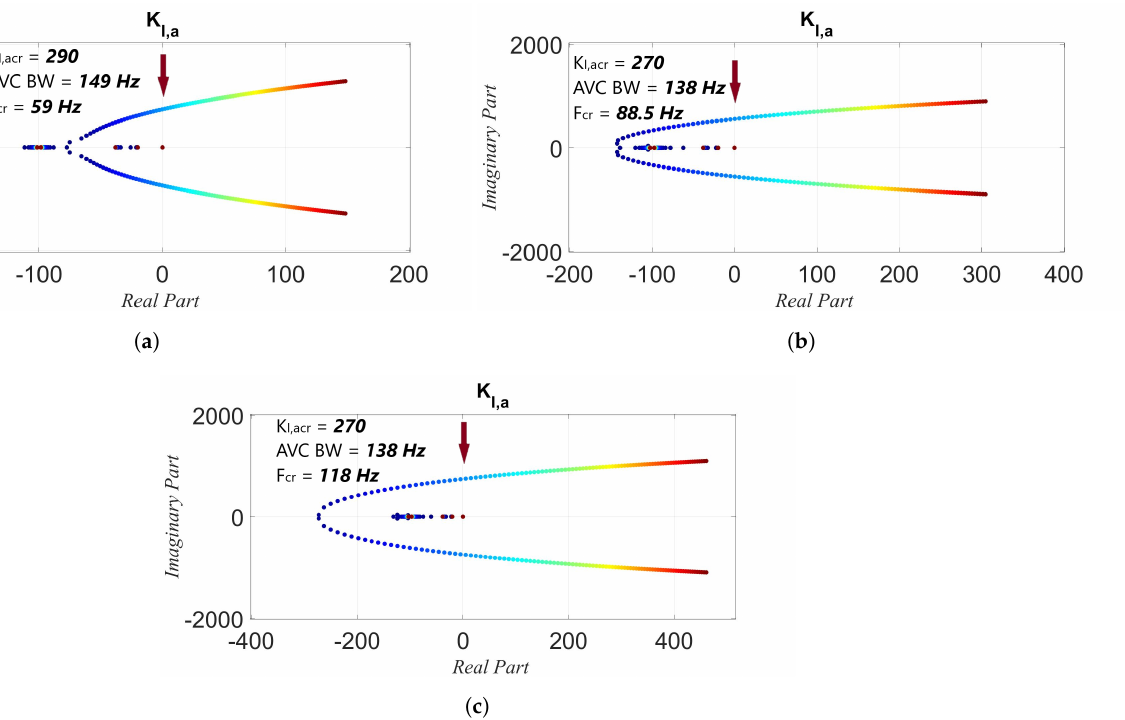
Figure 8. Eigenvalue − based stability analysis for different AVC filter cases in the weak grid case scenario (SCR = 1.5). The critical bandwidth of the AVC is identified after K I , a 0 varies from 0.1 (deep